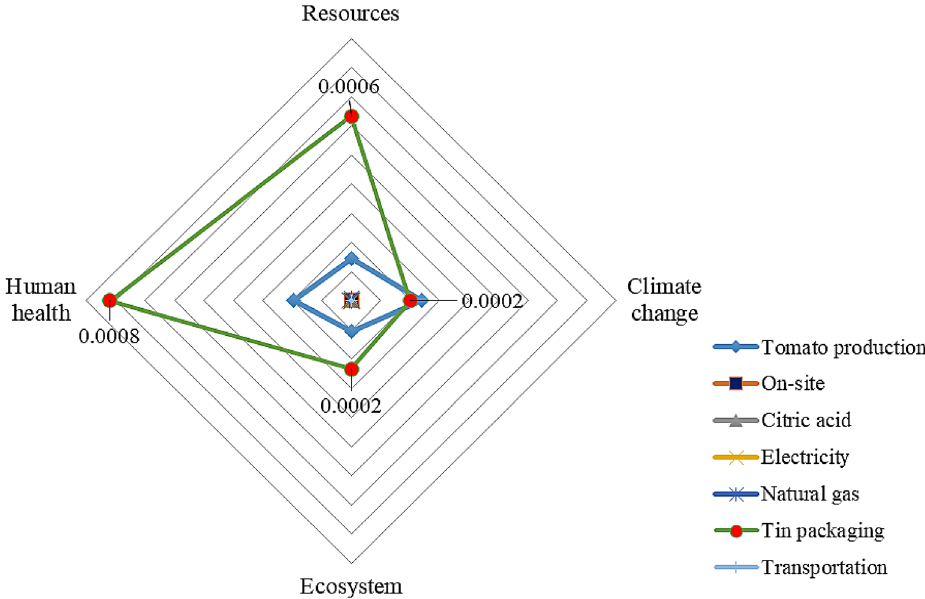
Figure 5. Normalized values of input damages in CTwJ processing and packaging for the appertization system.